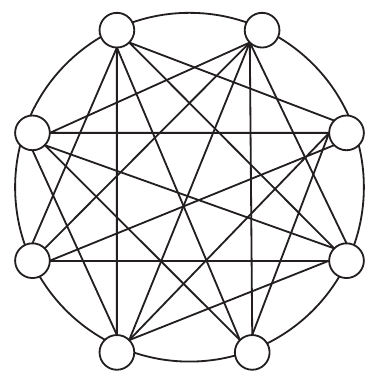
Figure 1. Global